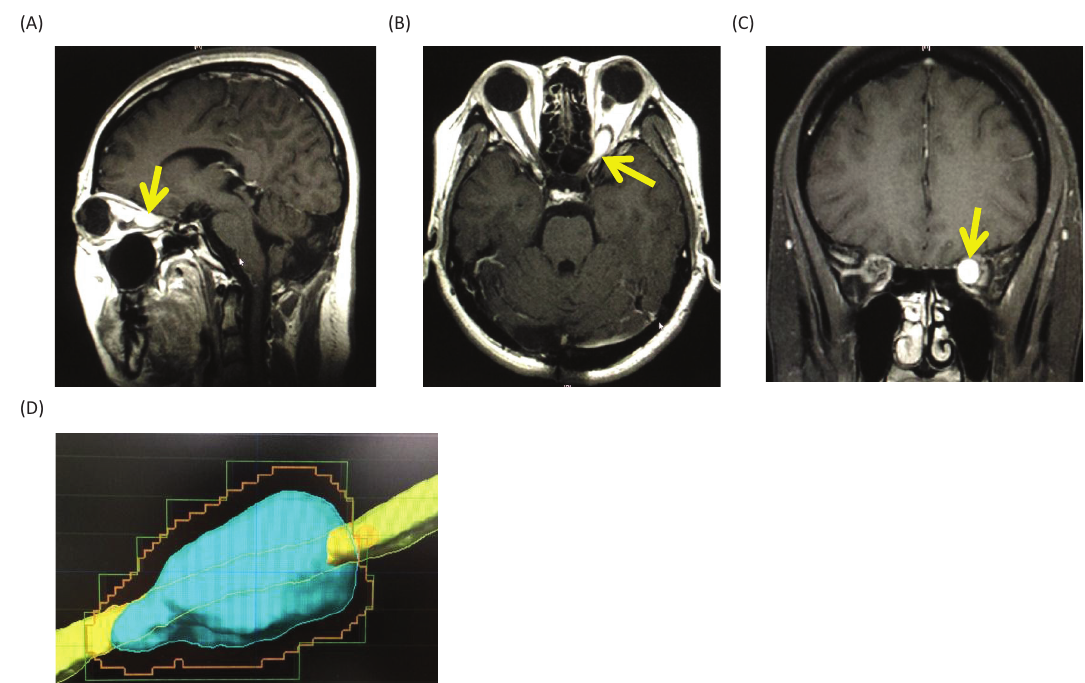
Figure 4. Magnetic resonance images before radiosurgery. (A) Gadolinium (Gd)-enhanced T1-weighted image, sagittal. (D) Three-dimensional planning MRI for radiosurgery. The light blue color indicates the tumor enveloping the optic nerve.